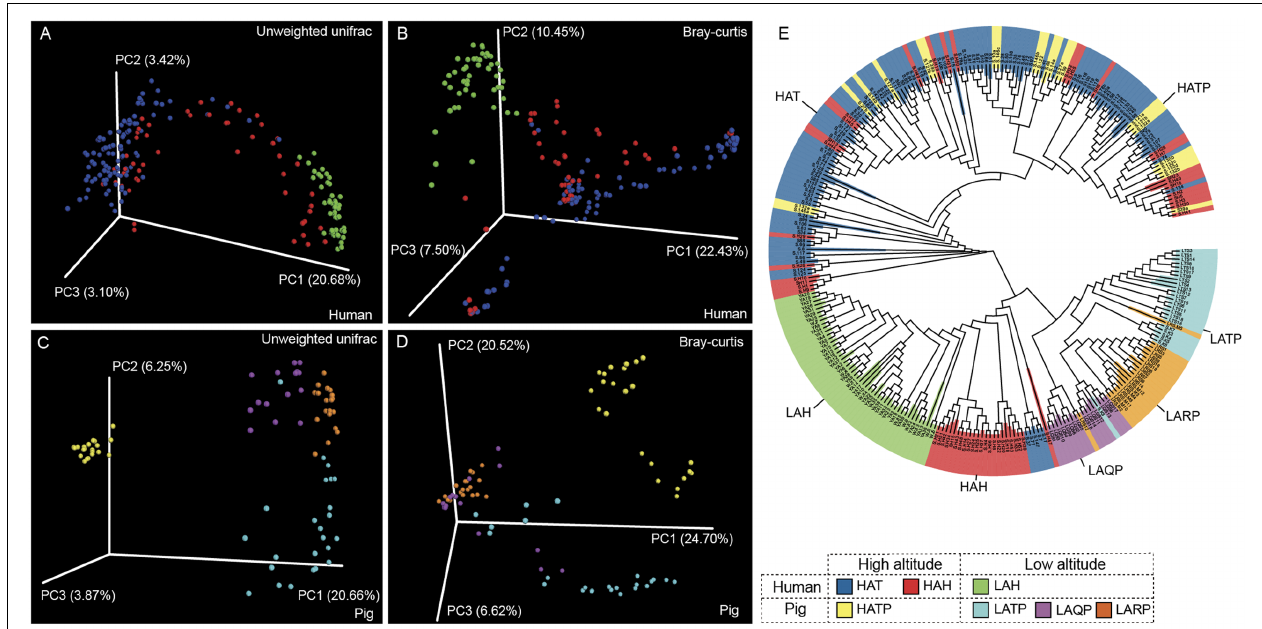
FIGURE 3 | Jackknifed beta diversity analysis. (A,C) Unweighted UniFrac- and (B,D) Bray–Curtis-based principal coordinates analysis (PCoA) of human and pig skin microbiomes were performed based on unweighted UniFrac distances and Bray–Curtis distances to assess microbiome differences between high- and low-altitude groups and (E) UPGMA tree of all samples; clustering was based on unweighted UniFrac